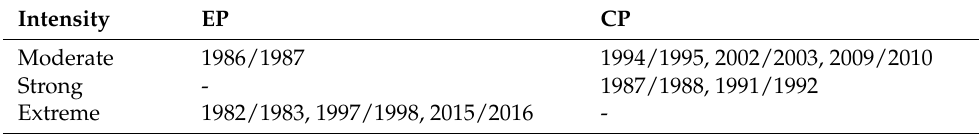
Table 1. From 1978 to 2017, the intensity of EN events ranged from moderate to very strong. Intensity EP CP Moderate 1986/1987 1994/1995, 2002/2003, 2009/2010 Strong - 1987/1988, 1991/1992 Extreme 1982/1983, 1997/1998, 2015/2016